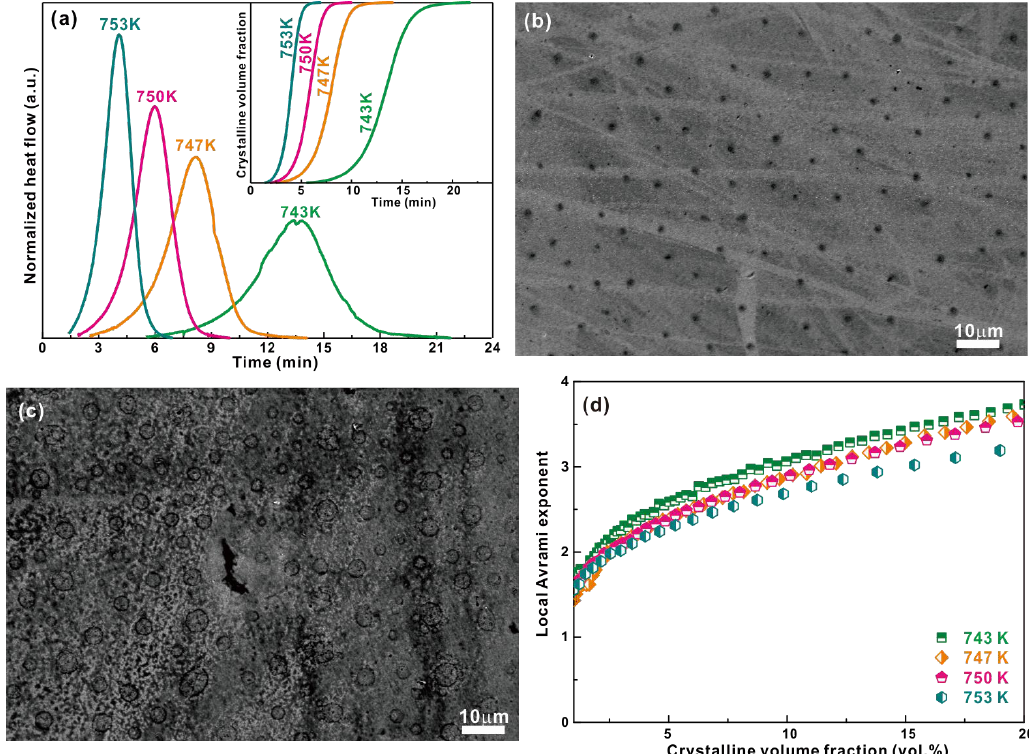
Figure 5. ( a ) Isothermal DSC curves as a function of annealing time for the (Cu 0.5 Zr 0.5 ) 84 Al 10 Co 6 BMGs and the corresponding crystalline volume fractions (see the inset); SEM images of the as-annealed (Cu 0.5 Zr 0.5 ) 84 Al 10 Co 6 samples at a heating rate of 40 K/min at 793 K ( b ) and 798 K ( c ), respectively, and ( d ) the Avrami exponents as a function of the crystalline volume fractions. Metals 2016 , 6 , 225